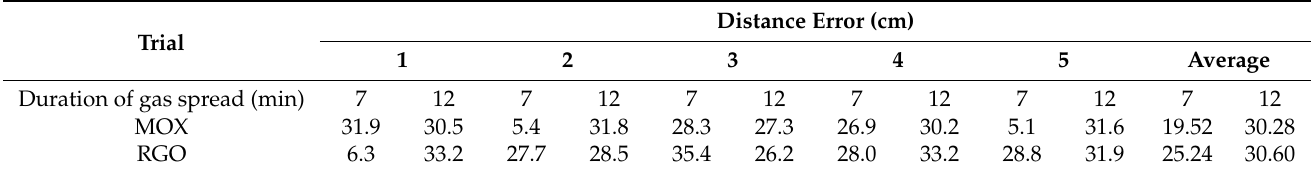
Table 3. The measured distance (error) of the predicted from the actual gas source location. Trial